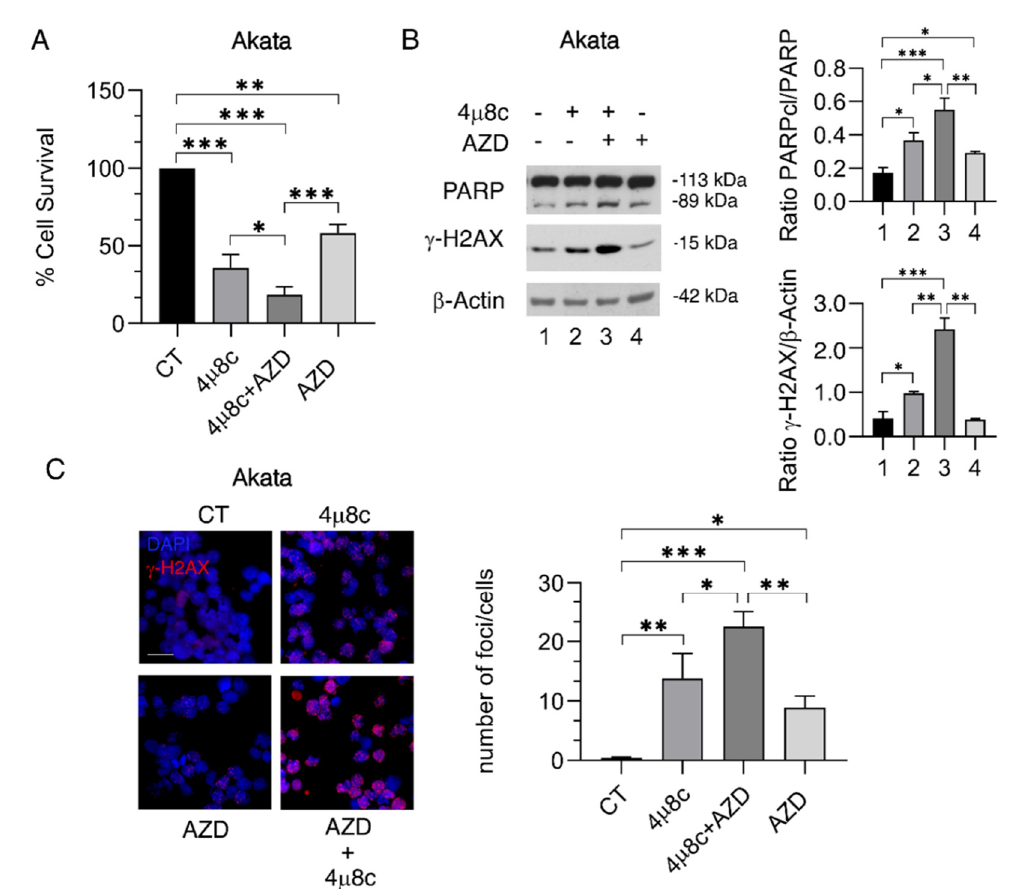
Figure 4. Inhibition of IRE1-alpha/XBP1 axis increases the cytotoxic effect of PARP inhibition in BL cells. Akata cells were pre-treated with 4 µ 8C (15 µ M) for 1 h followed by treatment with AZD2461 (AZD) (40 µ M). ( A ) After 24 h, the cell viability was measured by a Trypan Blue exclusion assay; the histograms represent the mean plus S.D. of live cells as percent of untreated control cells. ( B ) Protein expression level of PARP and γ -H2AX was evaluated by Western blot analysis. β -Actin was used as loading control and one representative experiment of three is shown. The histograms represent the densitometric analysis of the ratio of specific protein and the appropriate control of three different experiments. The data are represented as the mean plus S.D. ( C ) γ -H2AX foci (red) were assessed by IFA in Akata cell line. DAPI (blue) was used for nuclear staining. One representative experiment out of three is reported. The histograms represent the mean plus S.D. of the number of foci/cell obtained by three different experiments. Bars = 20 µ m. p value: * p < 0.05; ** p < 0.001; *** p <